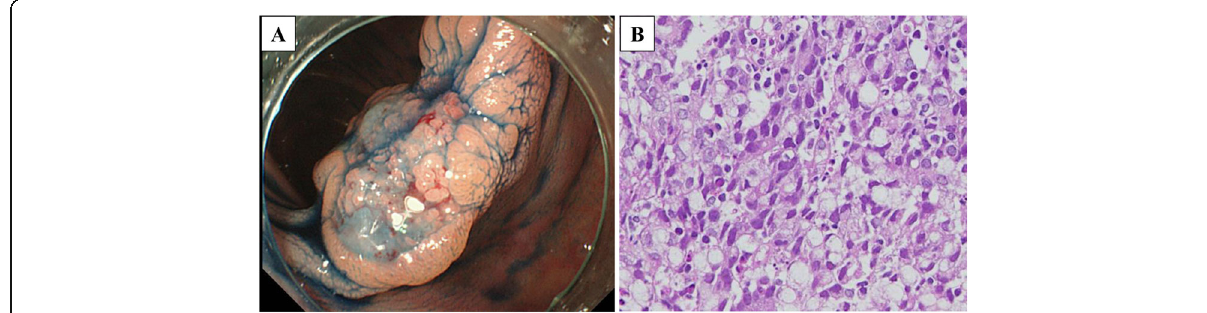
Fig.1 a Colonoscopy revealed a type 2 tumor of 13 mm in diameter at the transverse colon. b The biopsy specimen showed a poorly differentiated